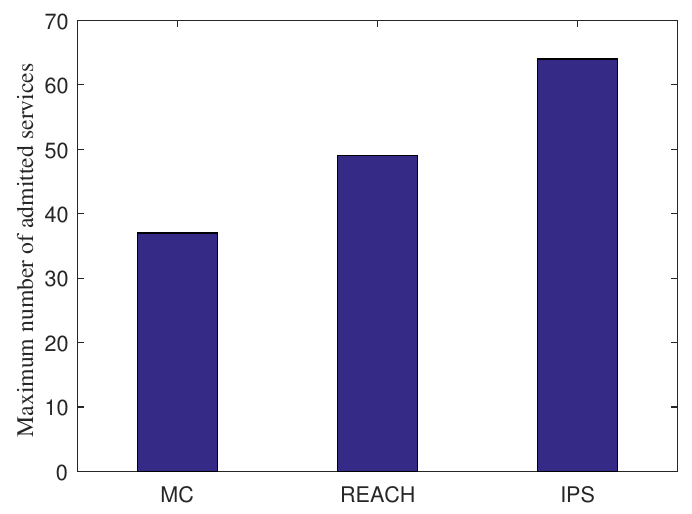
Figure 4. The maximum number of admitted services each scheme can